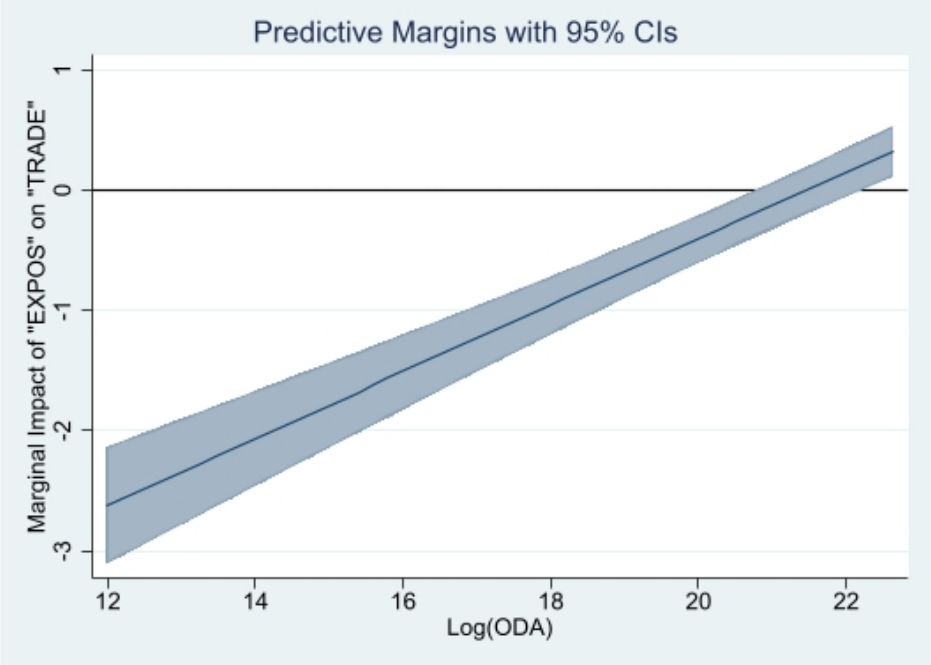
Figure 13. Marginal impact of “EXPOS” on “TRADE” for varying amounts of development aid. Source: Author.